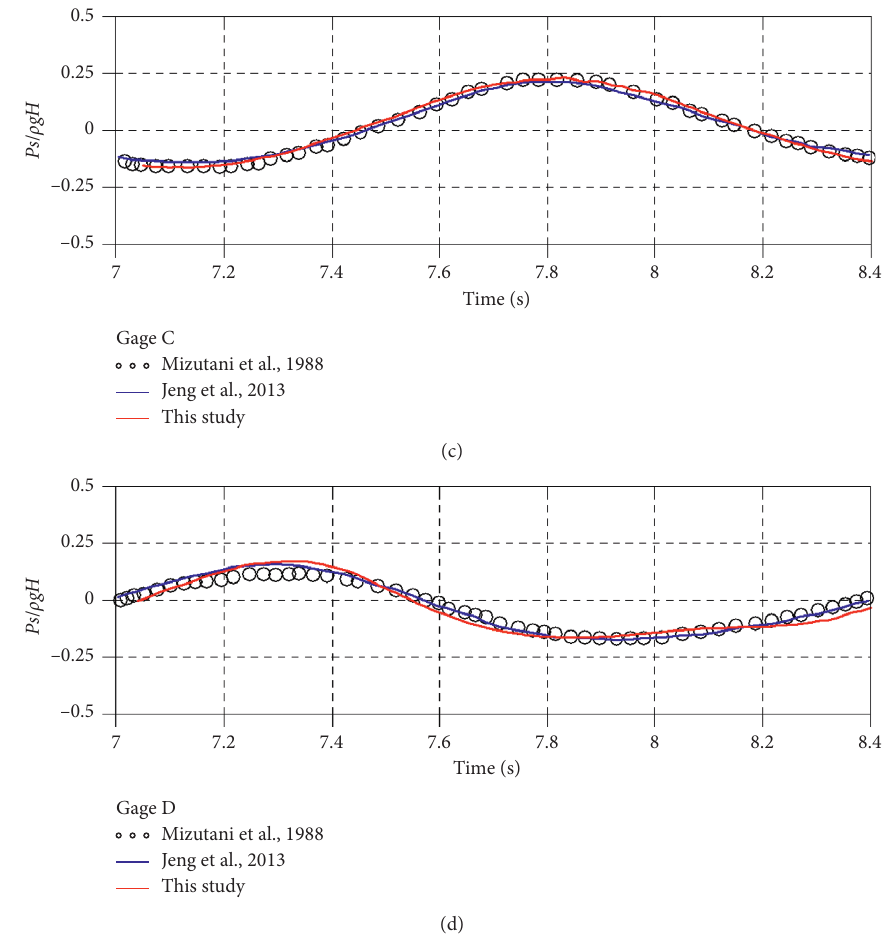
Figure 9: Comparison between measured and calculated dimensionless pore water pressures. (a) Location A ; (b) location B ; (c) location C ; (d) location D